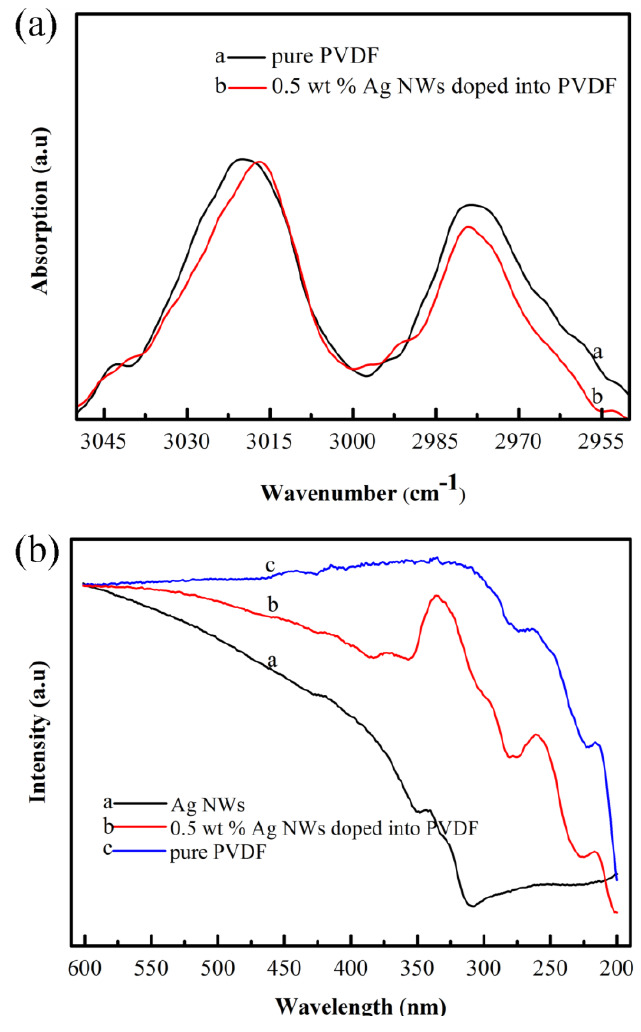
Figure 7. Characteristics of the interactions between PVDF matrix and the Ag NWs surfaces according to UV-Vis spectra ( a ) and ATR-FTIR ( b